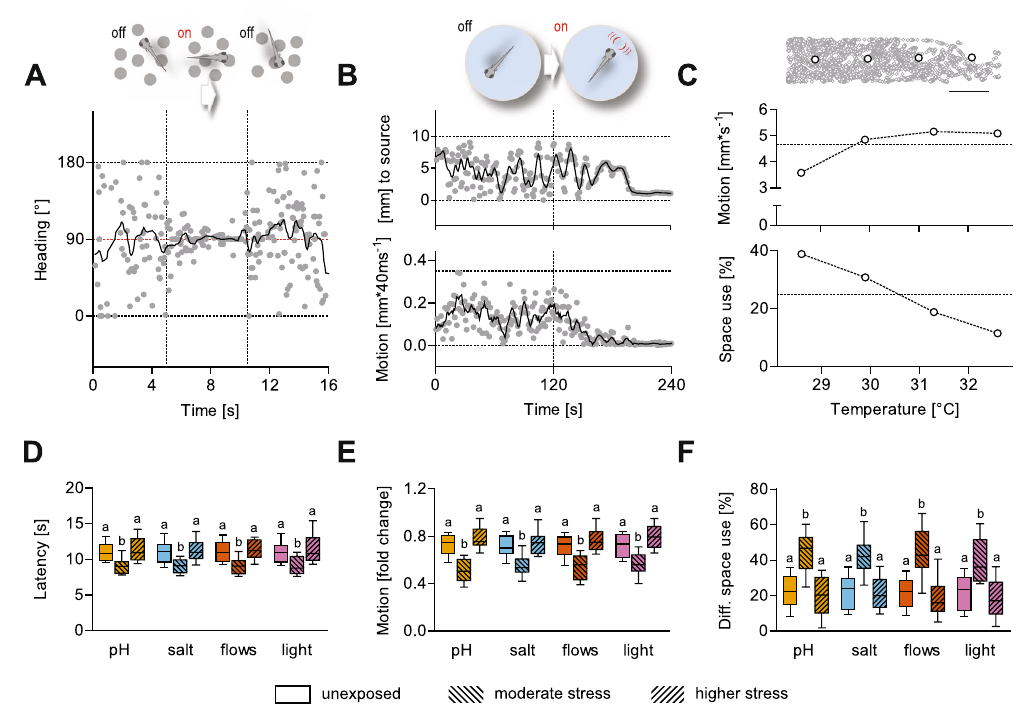
Figure 2. Innate behaviours and results. ( A ) Schematic (top) and representative trace (bottom) of an optomotor test depicting a larva’s heading, relative to the long axis of a rectangular swimming chamber, as a function of time. ( B ) Schematic showing the stimulation procedure (top) and representative traces of a larva’s distance to the stimulus source (middle) and swim velocity (bottom) before and after the onset of WMs (at 120 s). ( C ) Top, representative x-y coordinates (recorded every 40 ms over a 300 s period) of a freely behaving larva in a custom- made swimming chamber with a temperature gradient. White dots indicate the centre of each of the virtual quadrants. Scale bar, 5 mm. Middle, bottom, sample from a single larva, mean speed (middle) and proportion of time spent in each quadrant (bottom, space use, in %) over a 300 s period as a function of temperature. ( D – F ) Boxplots (whiskers: min to max) of latency ( D ), fold change in motion ( E ) and differential space use ( F ) values (from ( A ), ( B ) and ( C ), respectively) across groups of both control larvae (i.e., unexposed) and larvae with moderate and higher levels of stress caused by pH drop (orange), hyperosmotic medium (blue), strong flows (vermilion) and a squared pulse of light (purple) (see also Fig. 1 and ‘Results’). Letters indicate results of Bonferroni’s tests: (D), p < 0.01, ( E , F ), p < 0.001) after two-way ANOVAs. Sample size per group,